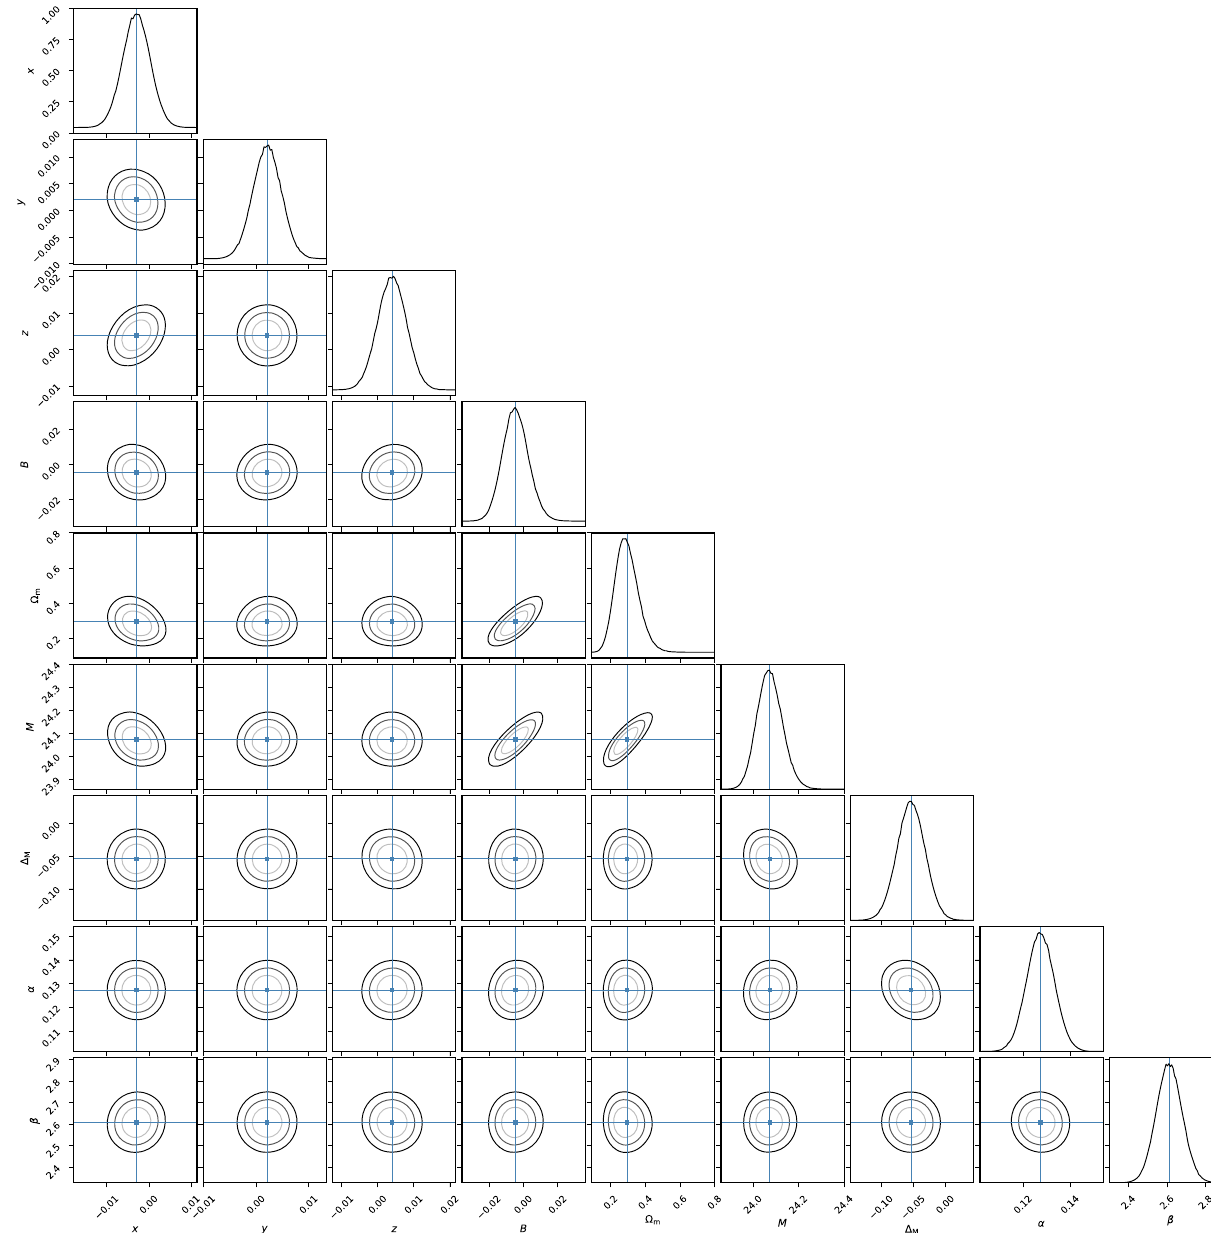
Fig. 8 Probability distribution functions of dipole parameters and nuisance parameters when fitted simultaneously for JLA data set